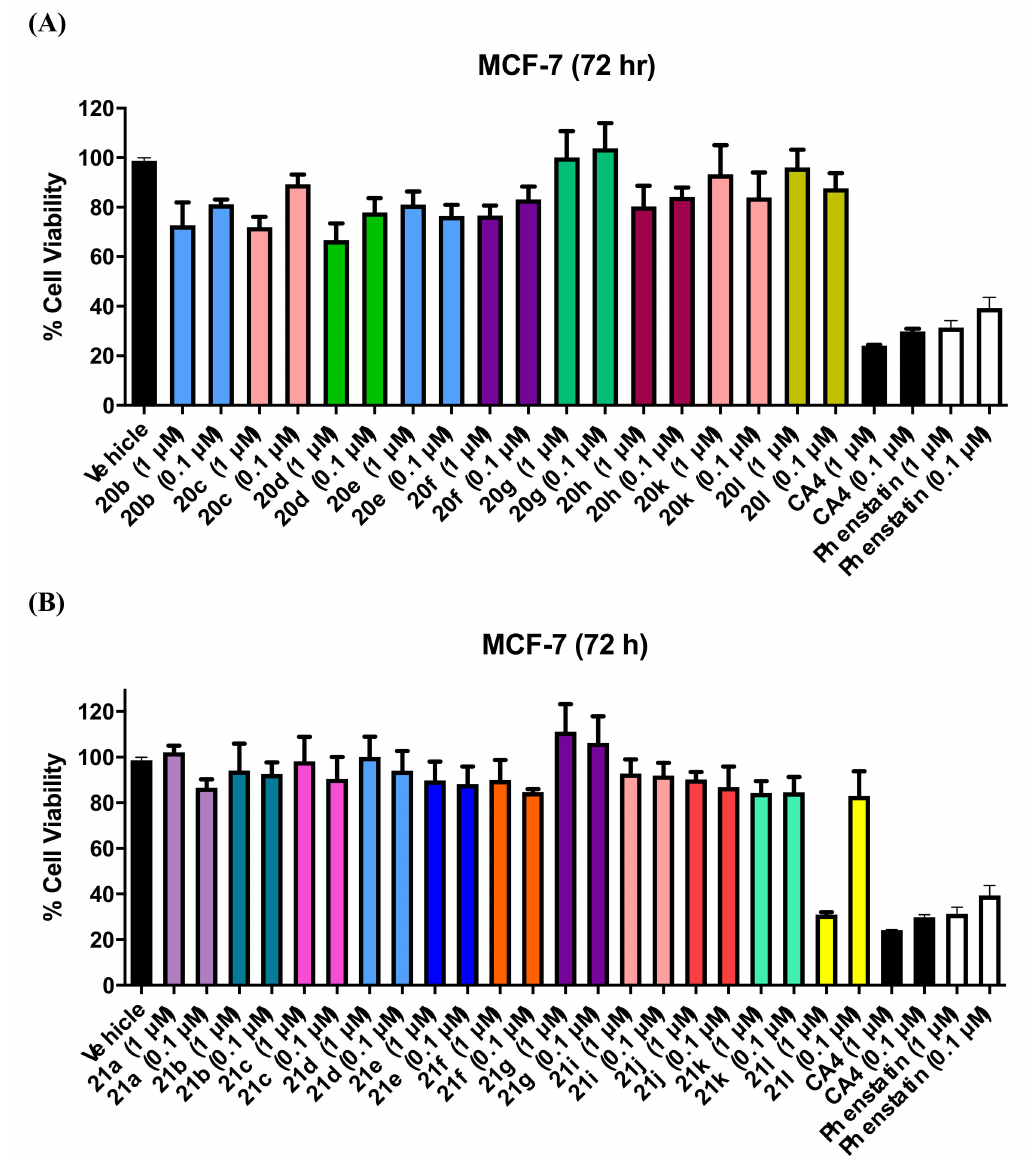
Figure 5. Preliminary cell viability data for ( A ) Series 3: 1-(diarylmethyl)-1 H -imidazoles 20b-h, k, l and ( B ) Series 4: 1-(diarylmethyl)-1 H -imidazoles 21a–g, i–l in MCF-7 breast cancer cells. Cell proliferation of MCF-7 cells was determined with an alamarBlue assay (seeding density 2.5 × 10 4 cells/mL per well for 96-well plates). Compound concentrations of either 1 or 0.1 µ M for 72 h were used to treat the cells (in triplicate) with control wells containing vehicle ethanol (1% v / v ). The mean value ± SEM for three independent experiments is shown. The positive controls used are CA-4 and